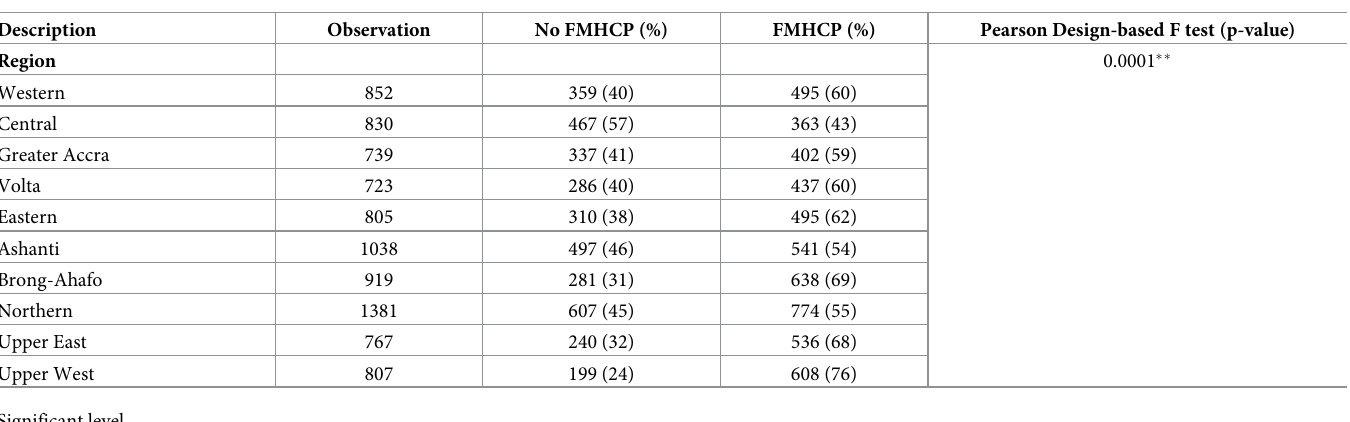
Stillbirth and perinatal mortality rate. Stillbirth birth rate for 2008 was 19 per 1000 live births, compared to 21 per 1000 live births in 2014, while perinatal mortality rate was 31 per 1000 live births in 2008 and declined to 27 per 1000 lives birth in 2014 (Table 6). Risk of stillbirth in the ‘free’ maternal health care policy group. Babies were 1.64 times more likely to be stillborn in the FMHCP group, compared to the no FMHCP group; aOR: 1.64; 95% CI: 1.02 to 2.65; p = 0.041. The results are similar across the Poisson and negative binomial regressions models, aPR: 1.34; 95% CI: 1.00 to 1.79; p = 0.045 respectively as shown in Table 2.